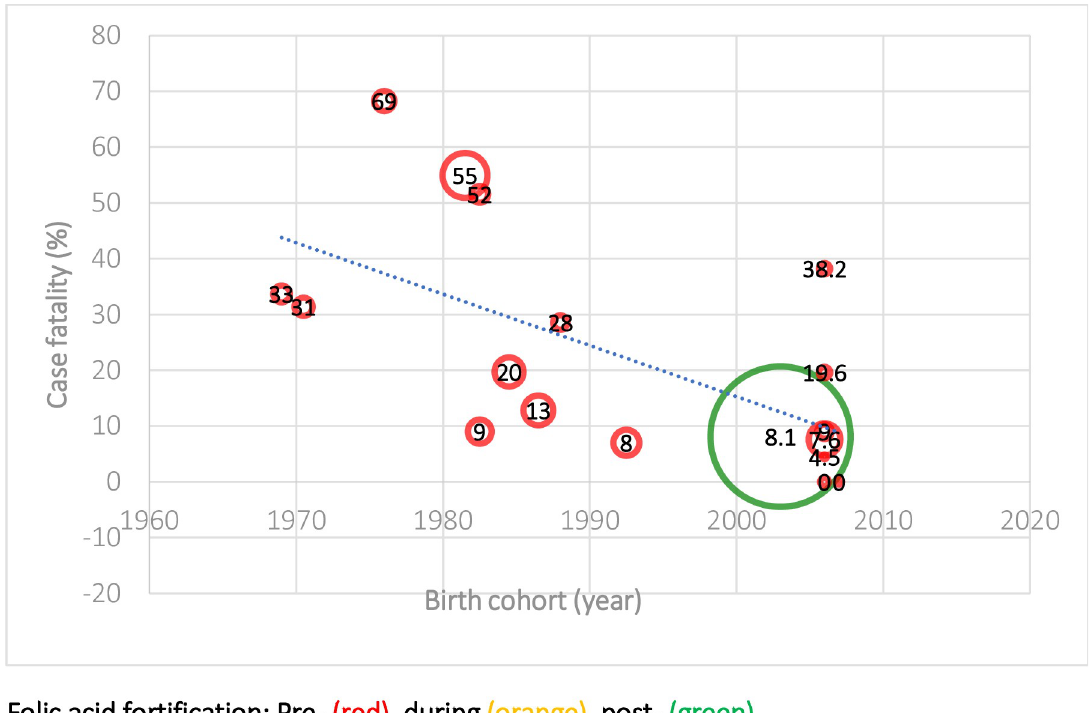
Fig 5. Infant case fatality from spina bifida in Australia, the U.S. and various European countries (1969–2003) [10,23,29– 31,37,38,42,43].